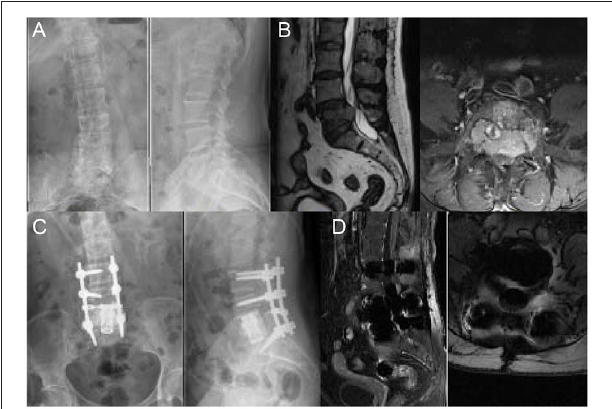
FIGURE 6 | A 59 years old woman with breast cancer bone metastasis in L5; Her preoperative Frankel grade was D. (A) Preoperative anteroposterior and lateral radiograph revealed uneven density in L5. (B) Preoperative sagittal T2-weighted and axial T1-weighted MRI revealed the metastatic lesion with an intraspinal lesion. The protrusion of soft tissue resulted in compression of the dura and canal stenosis. (C) Postoperative anteroposterior and lateral radiograph showed that posterior spinal fusion with anterior reconstruction was performed. (D) Postoperative sagittal T1-weighted